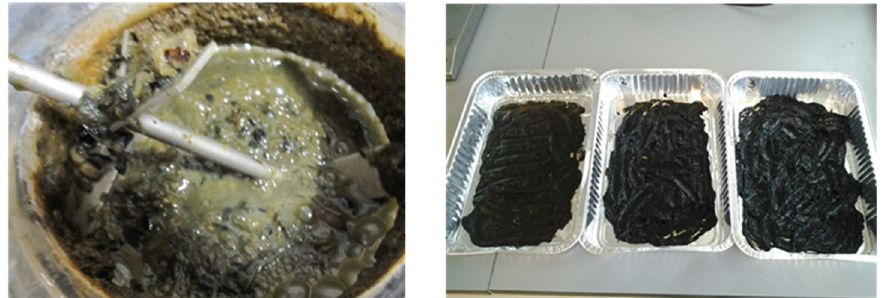
Figure 4. Images of digestate obtained right at the end of the experiment (nutrient-supplemented reactor) and digestate after six months of storage at ambient conditions.